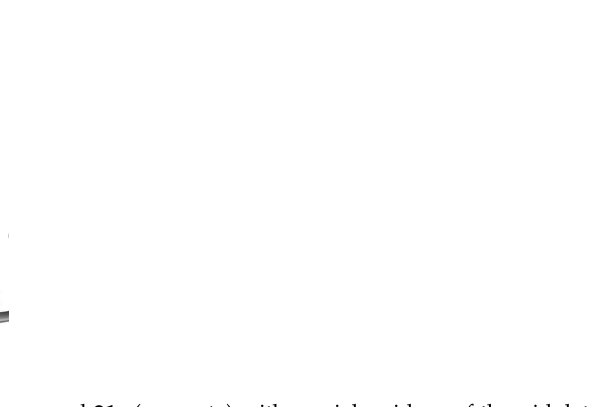
On the other hand, an efficient one-pot multicomponent reaction of 3-(2-bromoacetyl)